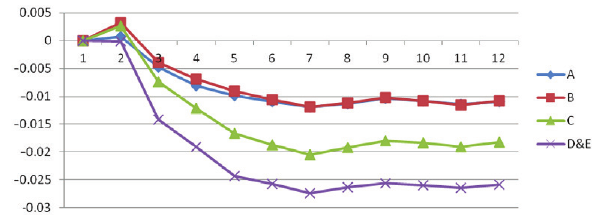
Figure 8f. Accumulated impulse response of PPI to shocks in CPI